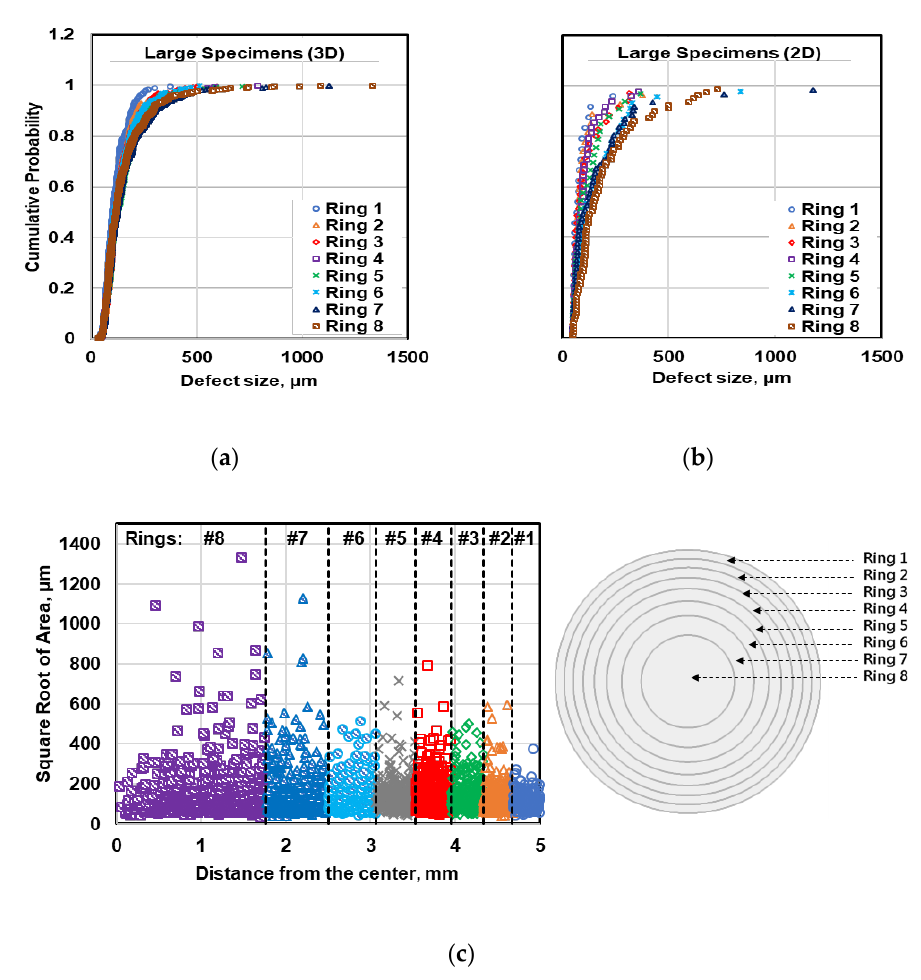
Figure 14. Comparison of the radial distribution of the defects within the cross section in large specimens using ( a ) µ CT data, ( b ) metallography data, and ( c ) illustration of defect distribution in radial direction within large specimens. Table 3. Kolmogorov–Smirnov (K-S) test results for comparing defect distribution in large specimens at different “Rings” using metallography data.